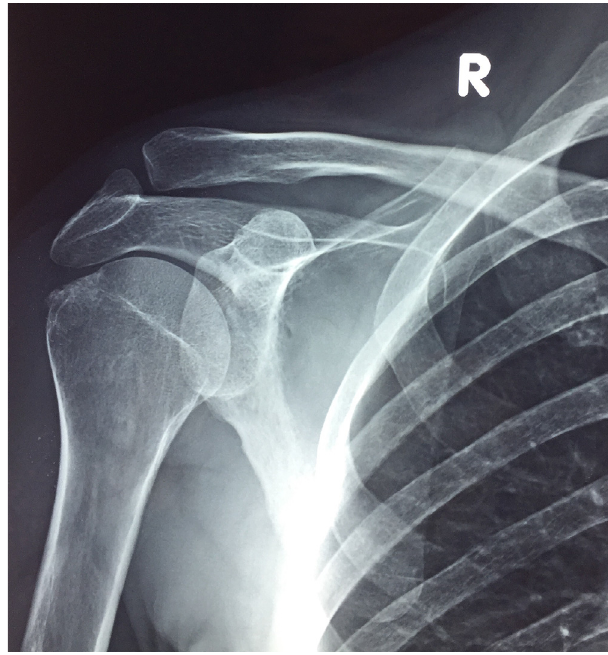
Figure 4. X-ray of the same patient 30 days after the needling and immediately after the end of the whole treating